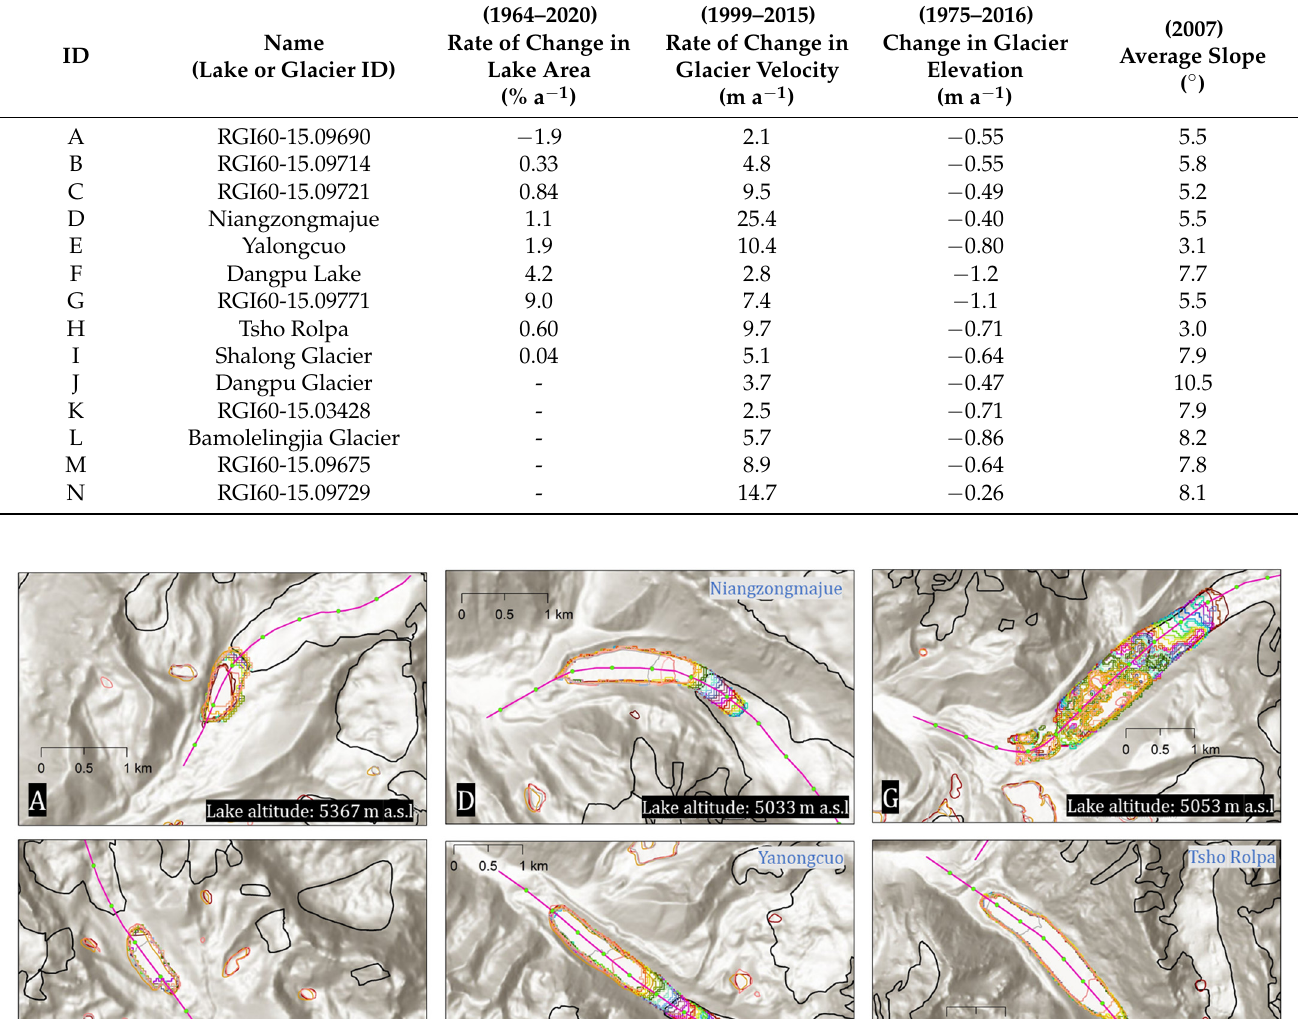
Table 5. Rates of changes and other related information for several lake-terminating glaciers (Glacier A-H) and land-terminating glaciers (Glacier I-N).